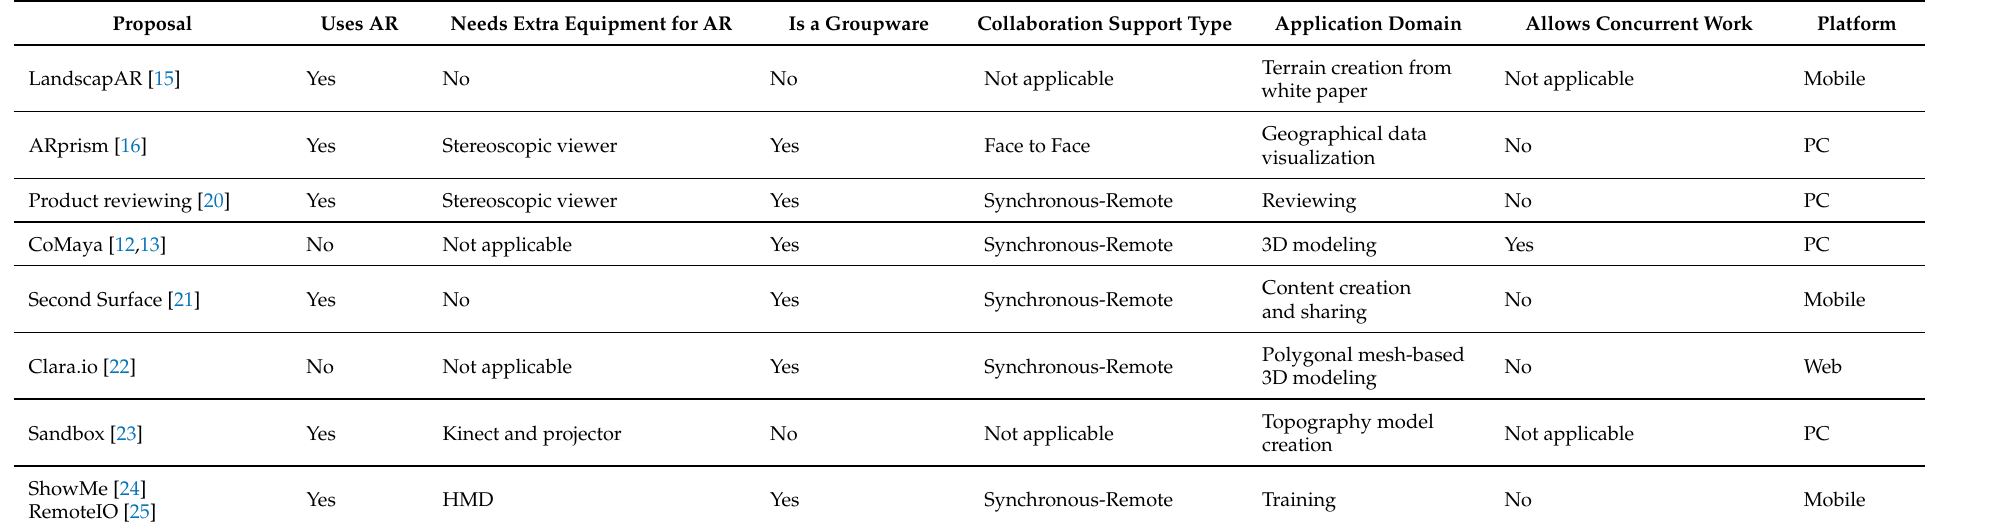
Table 1. Comparative table of the related work and our